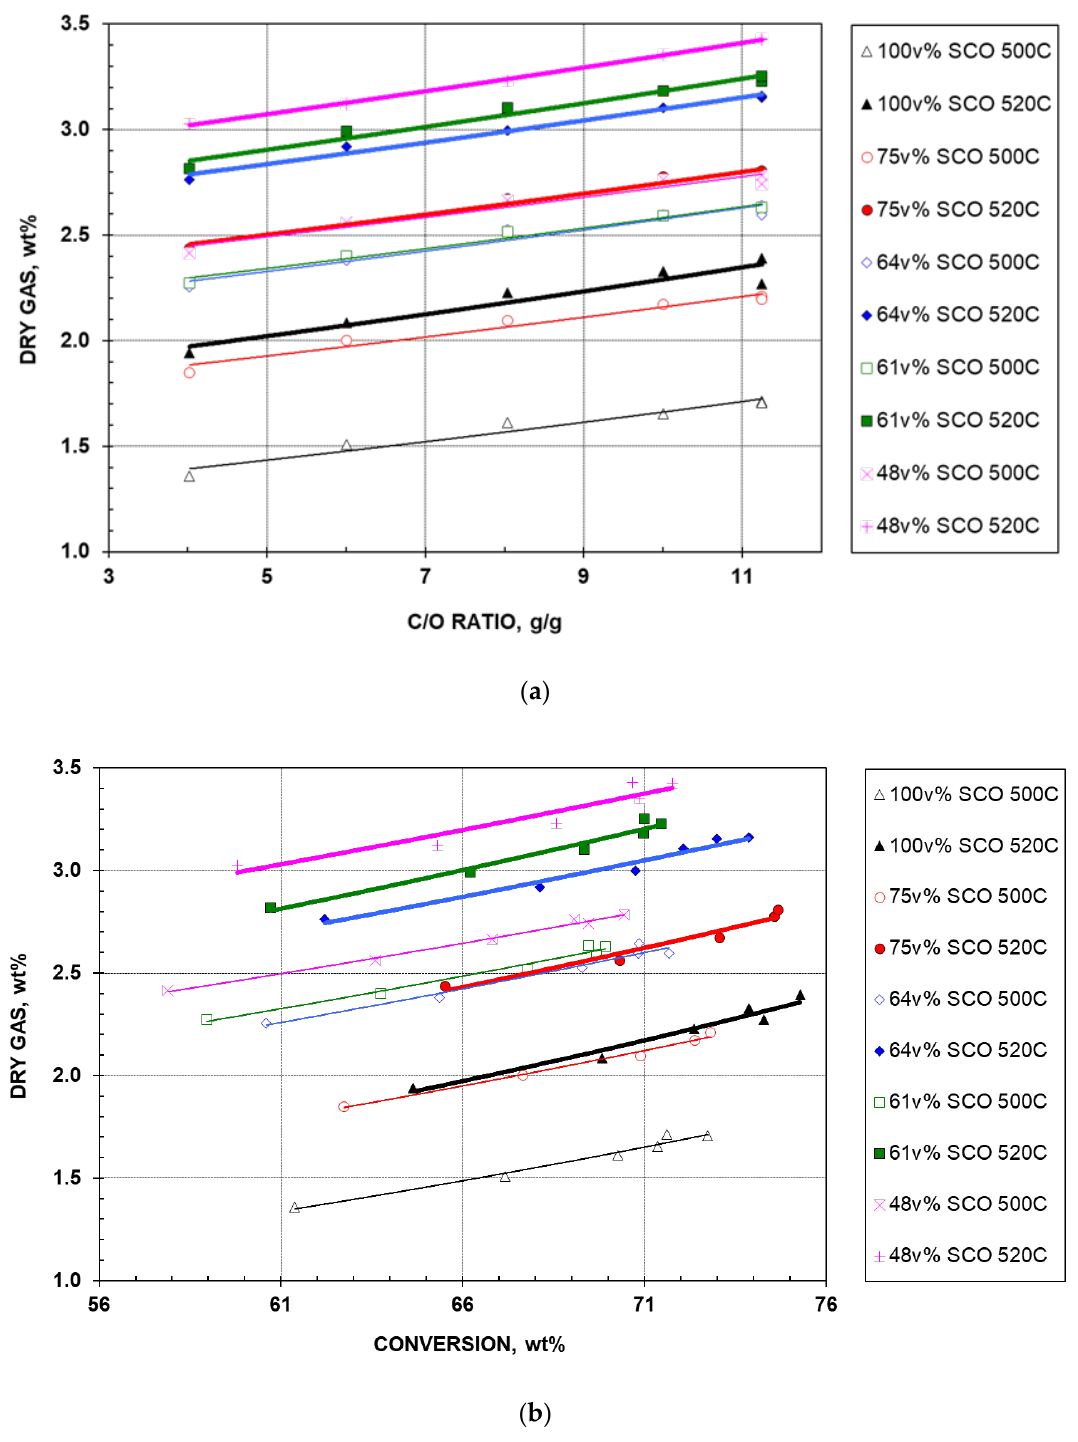
Figure 2. ( a ) Dry gas yield vs. C / O ratio at two reaction temperatures; ( b ) Dry gas yield vs. conversion at two reaction temperatures.